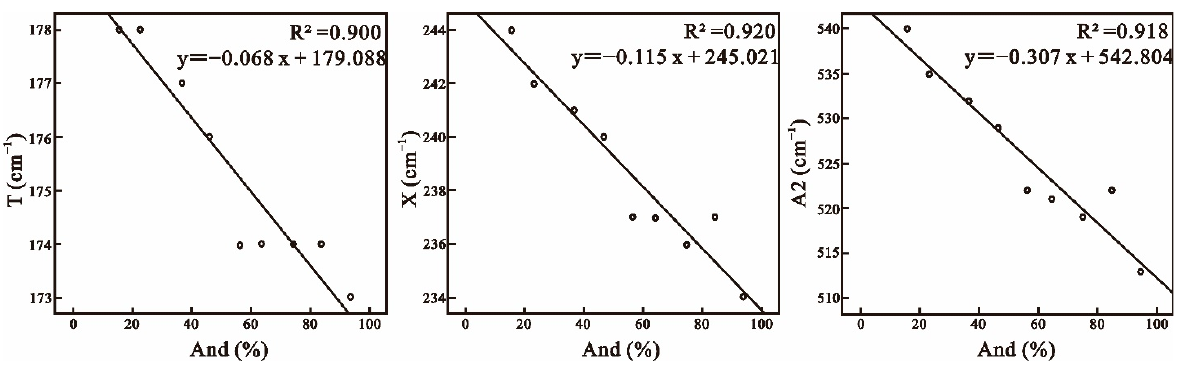
Figure 6. The linear fitting results between andradite content and Raman peaks (T, X, and A2). Table 5. The relationship between the garnet end member content and Raman peaks (cm − 1 ).